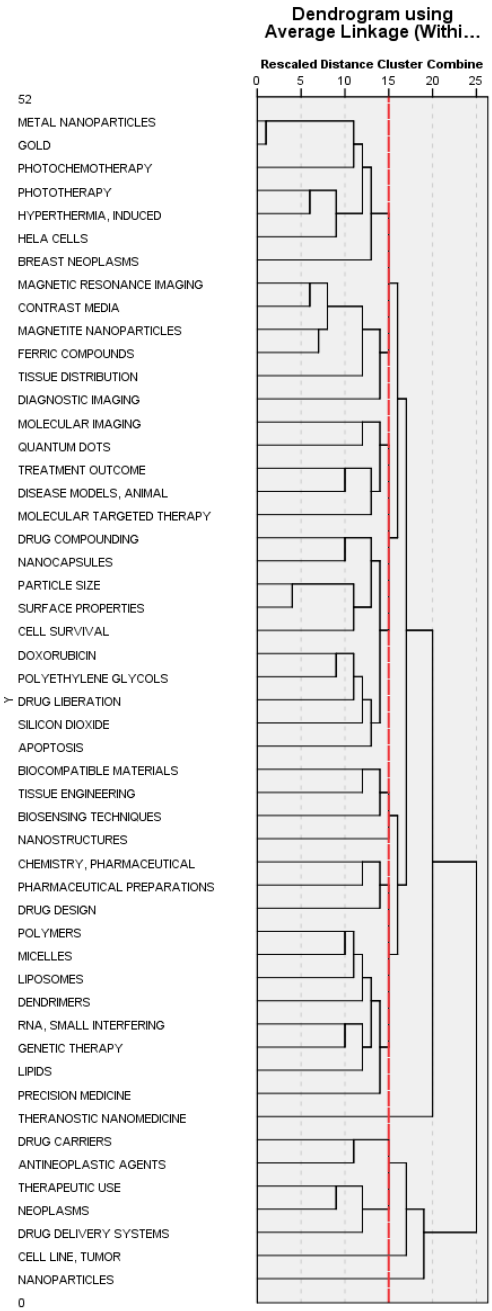
Fig. 3. Hierarchical clustering by co-word (within Group method) Fig 3. Hierarchical clustering by co-word (within Group method) the cluster deals with evolution of devices and it images devices to detect and analyze the diseased condition using